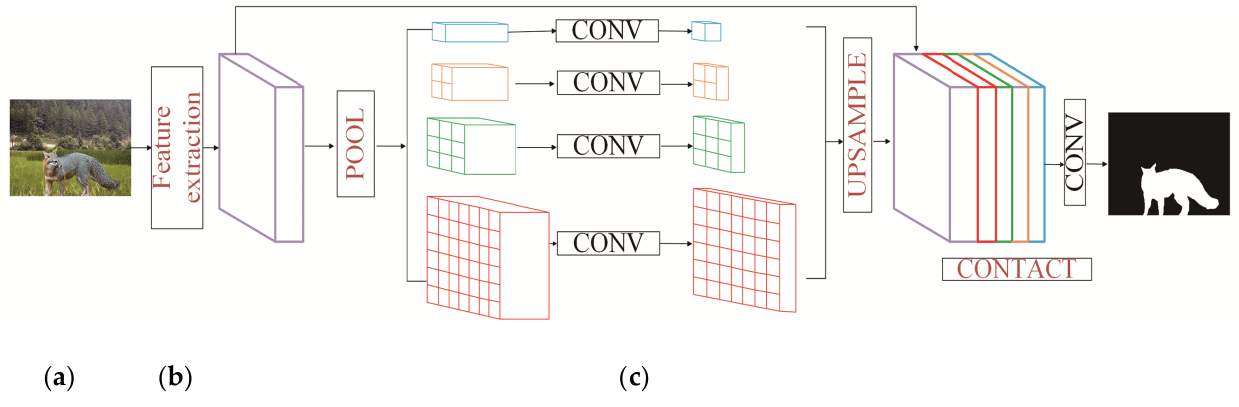
Figure 3. Overall structure of Mobile-Pspnet. ( a ) Input iamge; ( b ) Feature map; ( c ) Final prediction.